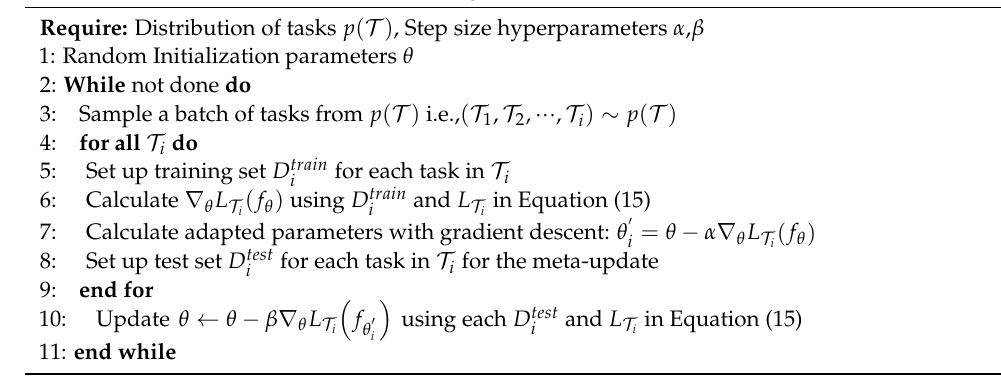
Algorithm 1 CNN-LSTM-ML Meta-Training